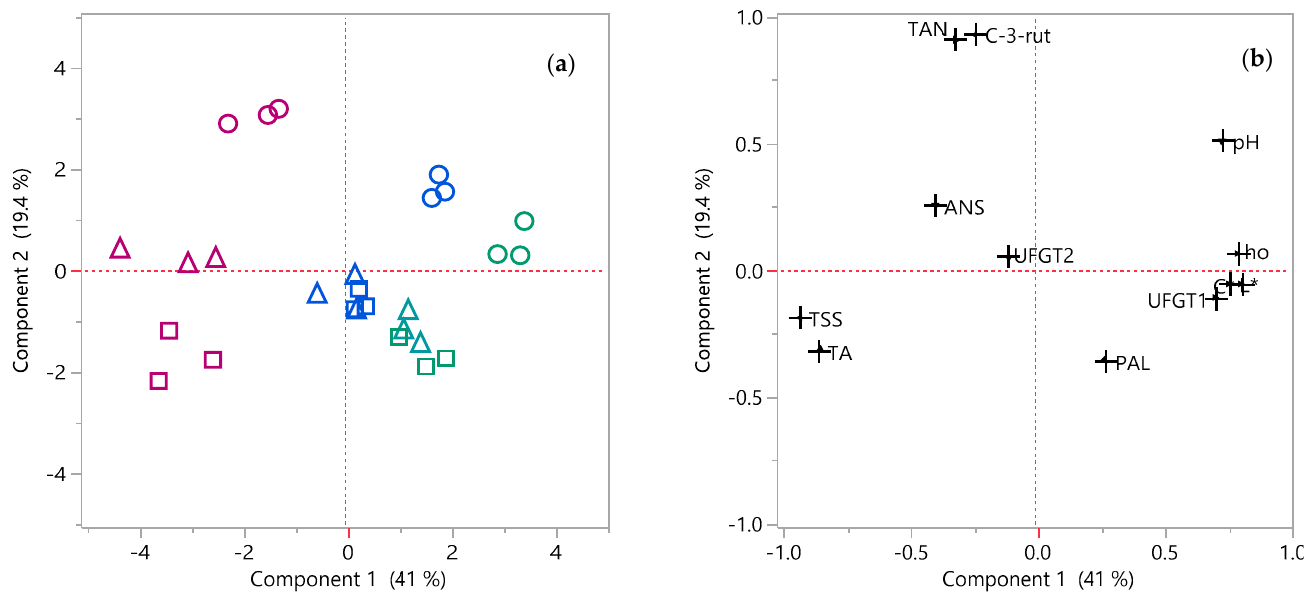
Figure 5. Principal component analysis (PCA) in cracking categories of fig peel after preharvest treatment with different concentrations of salicylic acid (SA), in year 1, according to variables, including L* , h o , C* , total soluble solids (TSS), titratable acidity (TA), pH, total anthocyanin, cyanidin − 3 − rutinoside (c-3-rut), expression of genes coding for phenyl alanine ammonia lyase (PAL), anthocyanidin synthase (ANS), UDP-flavonoid glucosyl transferase 1 (UFGT1), and UDP-flavonoid glucosyl transferase 2 (UFGT2). Categories: green color, C0 (sound fruit); blue color, C1 (slightly cracked); purple color, C2 (highly cracked). Treatments: circles, controls; triangles, treated with 1 mM SA; squares, treated with 2 mM SA. ( a ) Score plot; ( b ) load plot. Daggers indicate the position of each variable in load plot. Numbers in parentheses correspond to the percentage of the total variance explained by each